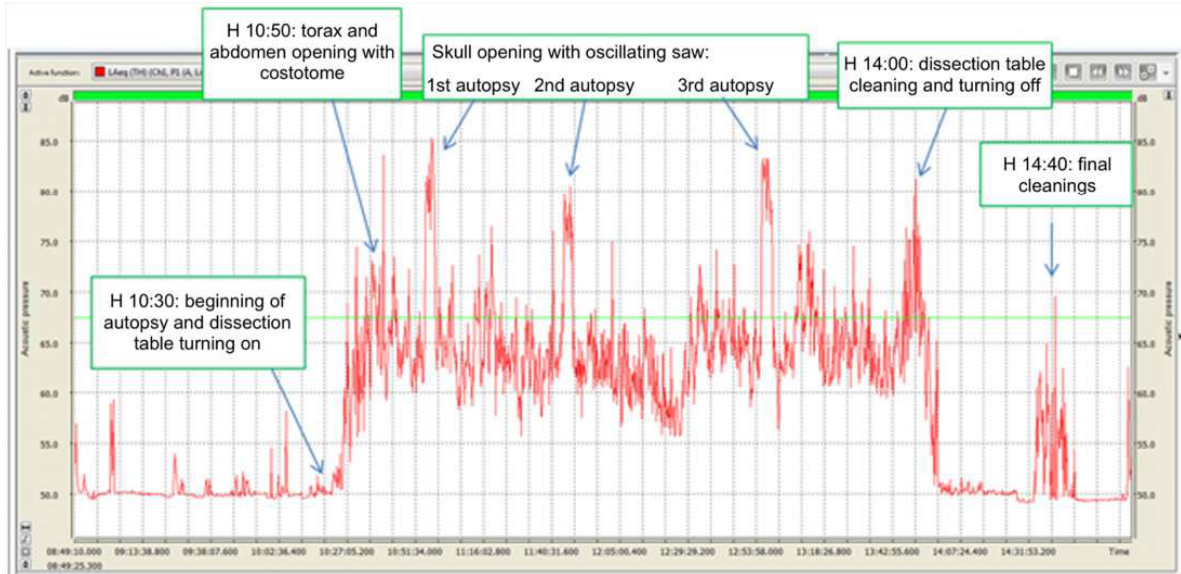
Figure 3. 30.09.2016. Acoustic emissions during 3 autopsies, each one performed on a different dissection table. Red line: equivalent sound level during T period of 15” (Leg), expressed as dB (A). Green line: equivalent sound level during the entire monitoring period (Leg), expressed as dB